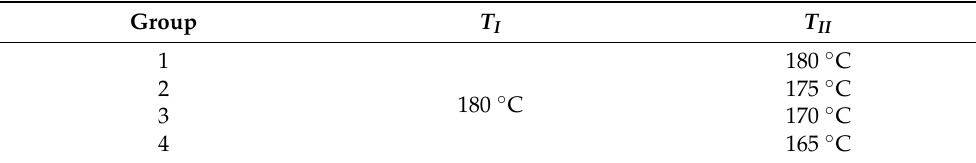
Table 4. Defined temperatures in the FEM model.